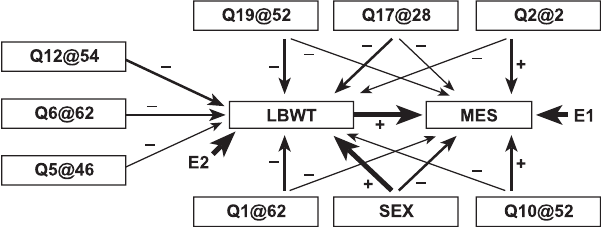
Figure 4. Graphical Representation of the SEM for Mesenteric Fat Pad Weight Genetic loci are indicated by Q followed by the chromosome number, and @ followed by the cM position of the LOD peak. Single-headed arrows indicate causal paths, and the thickness of each arrow is proportion to the effect size (path coefficient). A negative sign from a QTL to a trait indicates that the NZB allele is associated with high trait values. E1 and E2 denote unobserved residual error. DOI: 10.1371/journal.pgen.0020114.g004